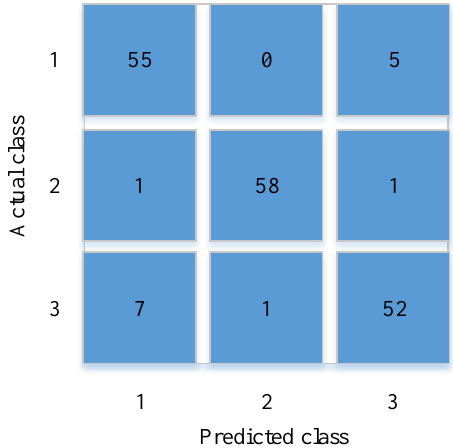
Figure 5. Confusion matrix for the SVM model. Note: Axis number representations: (1) B. cinereal spores; (2) P. xanthii spores; (3) P. cubensis spores.